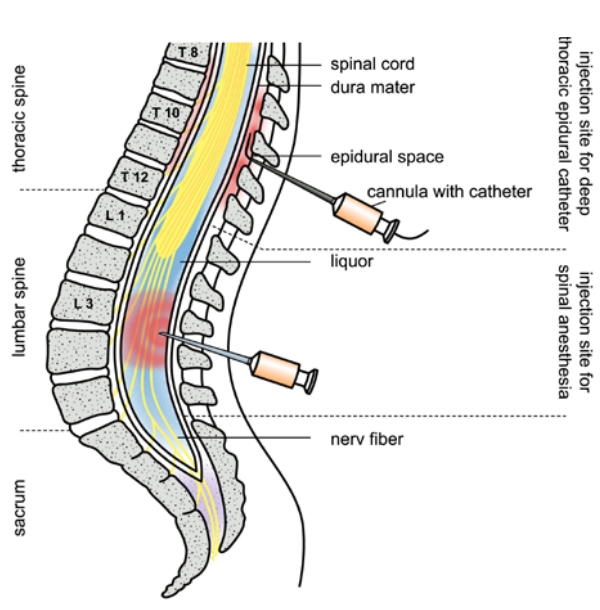
Figure 1 - Method of